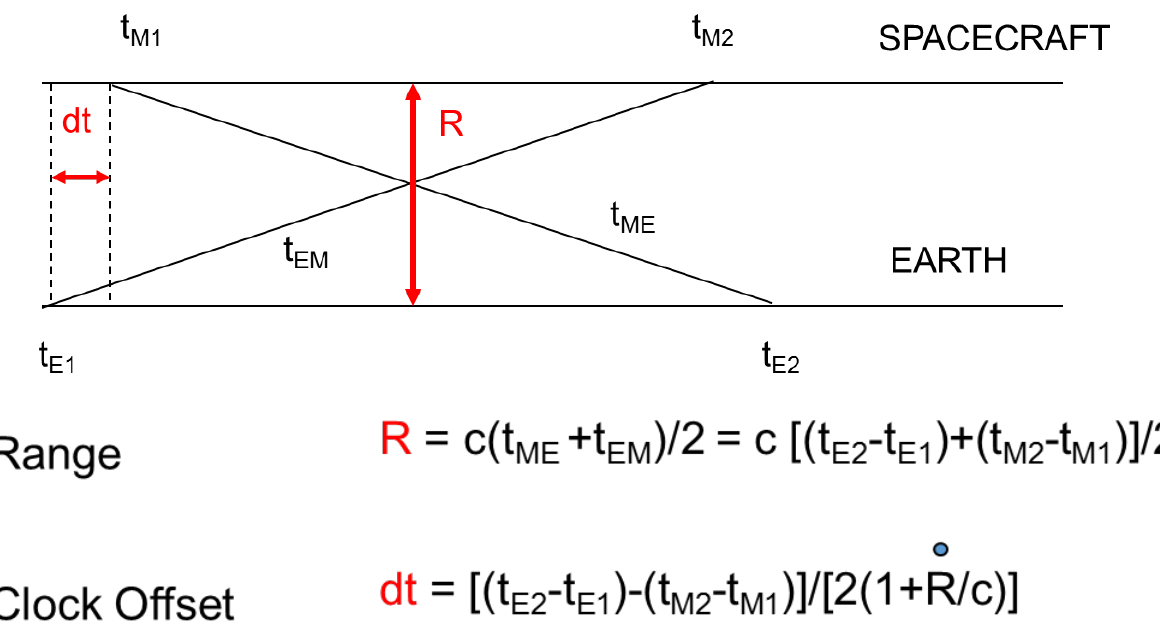
Figure 2. Computation of the instantaneous range R and the clock offset dt via Asynchronous Laser Ranging and Time Transfer. Multiple measurements of the range provide the time derivative of R between the Earth and spaceborne clocks that appears in the equation for the clock offset, dt.